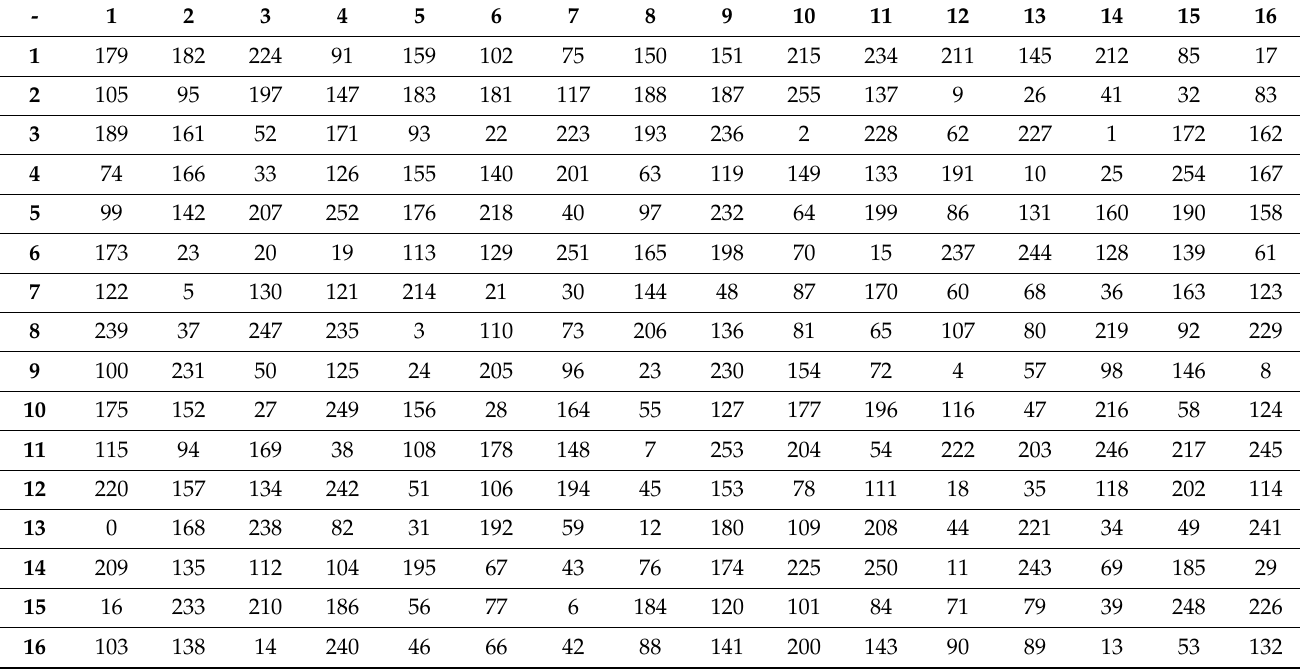
Table 2. Generated substitution